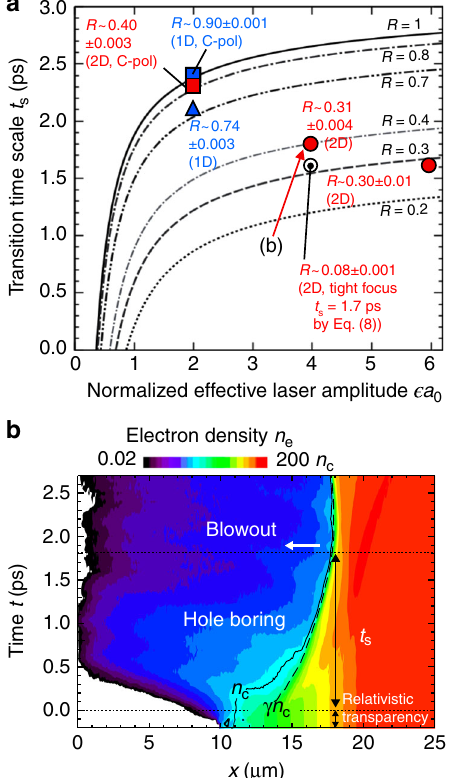
Fig. 4 Scaling of the transition time t s on the laser amplitude. a Dependence of the transition time from the hole boring to the blowout, t s , on the normalized effective laser fi eld amplitude ϵ a 0 for various re fl ectivities R ffiffiffi p where ϵ = 1 and 2 for linear and circular polarizations, respectively. Here, the relativistic 1D condition, that is α = 1 and β h = 1, and pre-plasma scale length L = 2 μ m are used. Theoretical lines given by Eq. (8) are presented by black lines. Red circles and red square are the 2D PIC simulation results for the quasi-1D geometry with widely focused (spot size of 60 μ m) linear-P and circular polarizations, respectively. The blue triangle (square) is the PIC simulation result for one-dimensional geometry with linear (circular) polarization. The white circle corresponds to the PIC simulation result for a tightly focused (spot size of 1.5 μ m) P-polarized laser pulse in two- dimensional geometry, for which the corresponding theoretical value of t s assuming the 2D relativistic condition α = 2 and β h = 1 in Eq. (8) is presented. Re fl ectivity R obtained in each simulation is also shown. b Electron density pro fi le in position-time space obtained by the 2D simulation shown in a at ϵ a 0 = 4 with the wide laser focal spot. The presented density is the averaged value over the central region y = ± 1 μ m with respect to the laser axis. Black solid and dashed curves are contour lines for critical density n c and relativistic critical density γ n c ,